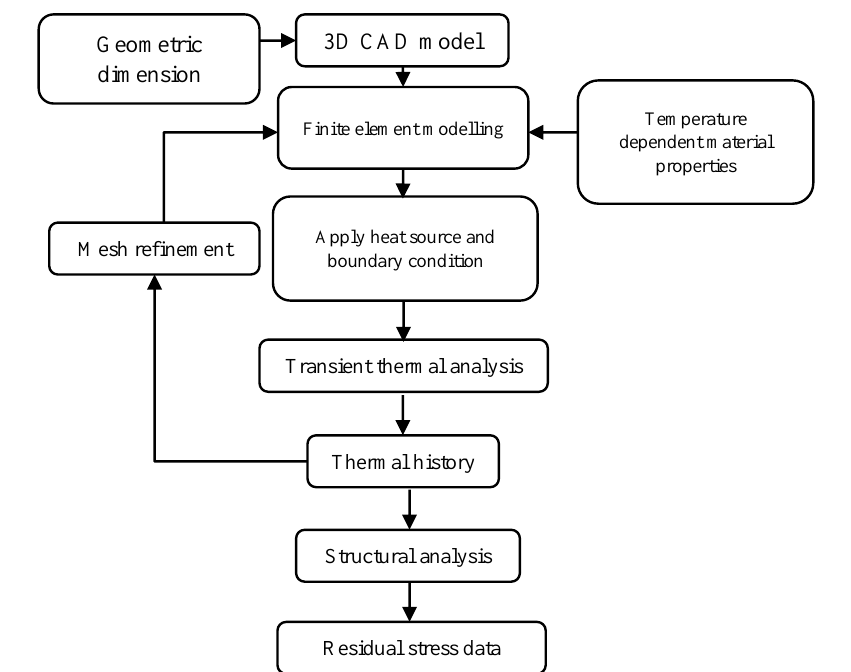
Fig. 1. The methodology followed in the present